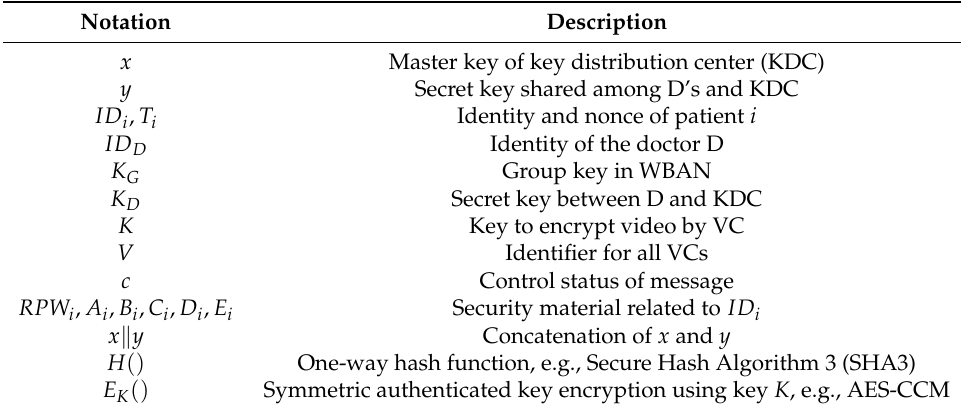
Table 1. Notations used in the proposed security